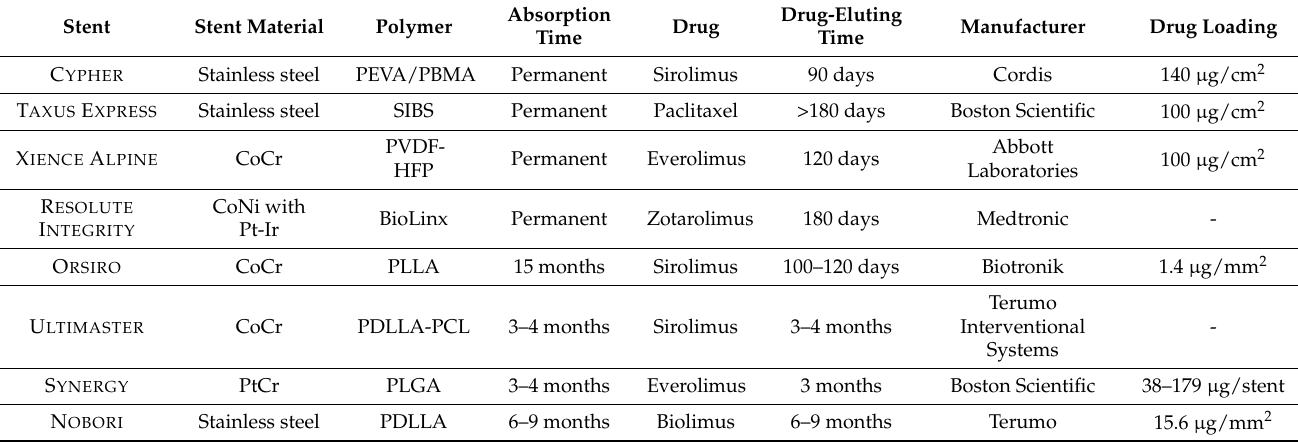
Table 1. Overview on selected commercially available DES (modified according to [25], drug loading data was taken from [27]). Stent Stent